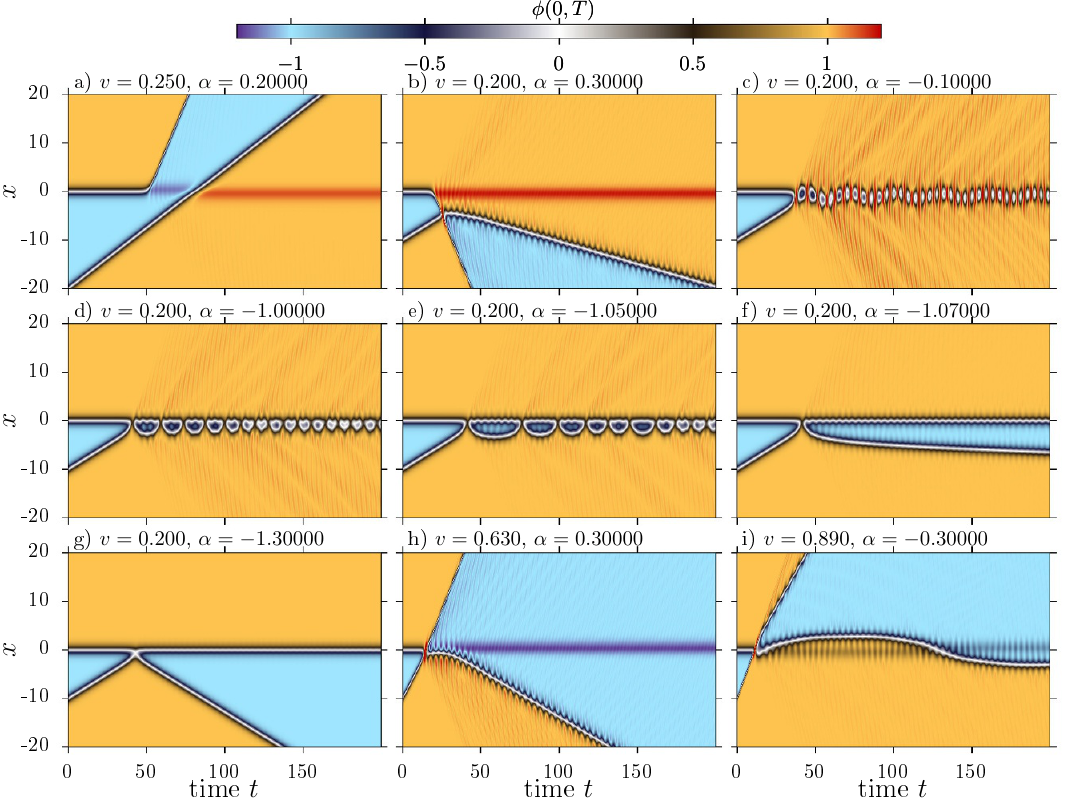
Figure 24 . Di(cid:11)erent scenarios of antikink-(kink-on-impurity) ( (cid:22) K + K 0 ) collisions, mostly for velocity v = 0 : 2. The other velocity values are a) v = 0 : 25, h) v = 0 : 63 and i) v = 0 : 89. Further, the parameter values are a) (cid:11) = 0 : 2, b) (cid:11) = 0 : 3, c) (cid:11) = (cid:0) 0 : 1, d) (cid:11) = (cid:0) 1 : 0, e) (cid:11) = (cid:0) 1 : 05, f) (cid:11) = (cid:0) 1 : 07, g) (cid:11) = (cid:0) 1 : 3, h) (cid:11) = 0 : 3 and i) (cid:11) = (cid:0) 0 :